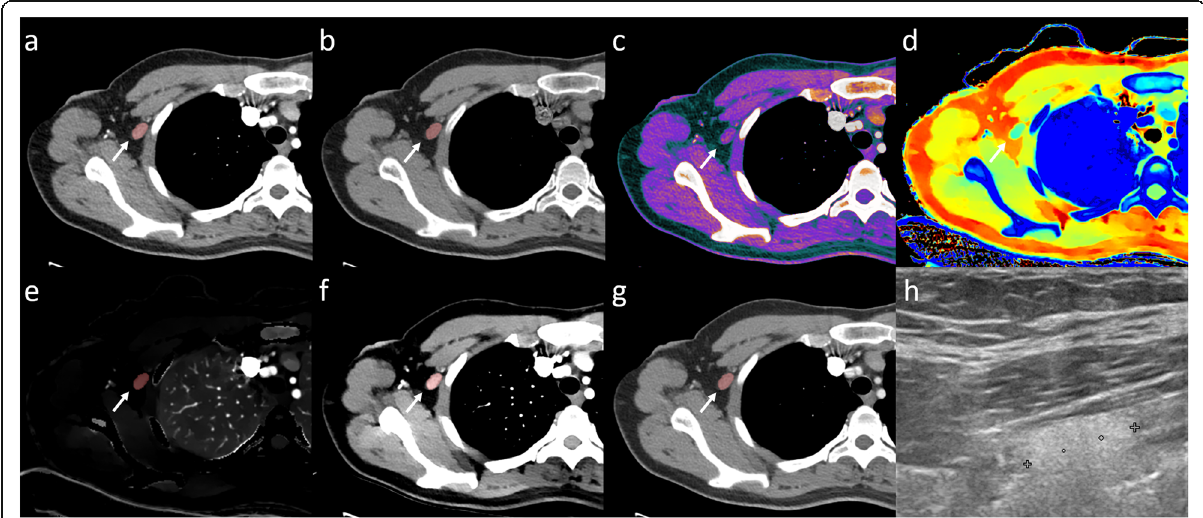
Fig. 5 Arterial phase dual-layer spectral computed tomography (DLSCT) examination of a woman with a high attenuating lymph node in the right axilla. The lymph node shows high conventional CT HU ( a ), Δ contrast enhancement ( c ) (conventional CT (HU) ( a ) minus virtual non- contrast (HU) ( b )), low Z effective ( d ), high iodine density ( e ), and spectral slope ((mono-energy 40 keV ( f ) − mono-energy 100 keV ( g ))/60 keV). Based on the cutoff values, DLSCT diagnosed the lymph node as metastatic. Axillary ultrasonography ( h ) described the lymph node as non- suspicious and consistent with silicone uptake from a previously known breast implant leakage. Sentinel lymph node biopsy was negative for metastatic disease but showed significant silicone